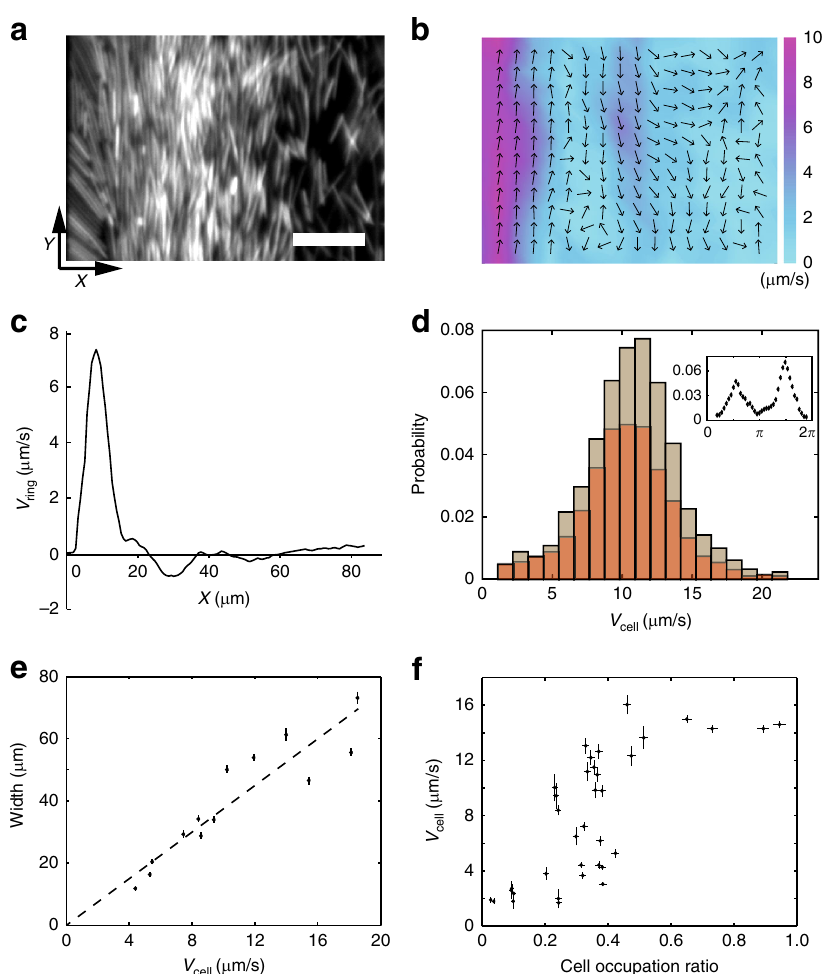
Fig. 2 Self-organization of two adjacent motile rings at the edge of a P. mirabilis suspension drop (arti fi cial colony). a Fluorescent image of the drop edge ( “ Methods ” ). Scale bar, 10 μ m. See Supplementary Movie 6 (phase contrast) and Supplementary Movie 7 ( fl uorescence). b Time-averaged collective velocity fi eld of cells in the region of panel a computed by optical fl ow analysis ( “ Methods ” ) based on phase contrast images. The collective velocity fi eld was averaged over a duration of 10 s. Arrows represent velocity direction, and colormap represents velocity magnitude (with the color bar provided to the right, in μ m s − 1 ). c The mean tangential speed of collective cellular motion (based on optical fl ow data) plotted against the distance from suspension-drop edge. Following the coordinate system speci fi ed in panel a , positive value of speed indicates motion along + Y axis, i.e., along CW direction viewed from above the suspension drop, and X = 0 is set at the position of drop edge. d Speed distribution of individual bacteria obtained by single-cell tracking at the inner motile ring where the magnitude of mean tangential speed was larger than 1/3 of the maximum CCW velocity magnitude in panel c . Brown and orange columns represent statistics for cells moving in CCW and CW direction, respectively. Inset: Distribution of velocity direction of individual bacteria; 3/2 π and 1/2 π correspond to − Y and + Y directions, respectively. Also see Supplementary Fig. 1. e The width of inner motile ring plotted against the mean tangential speed of collective motion at the outer motile ring. Dashed line is a linear fi t with R 2 = 0.84. Error bars indicate standard error of the mean ( n = 1200 measurements in three biologically independent samples). f The mean tangential speed of cells plotted against cell occupation ratio in the 10- μ m-wide outmost rim of the suspension drop (corresponding to the region of outer motile ring in naturally developed colonies). Horizontal error bars indicate standard error of the mean ( n = 300 measurements in three biologically independent samples); vertical error bars indicate standard deviation ( n = 10